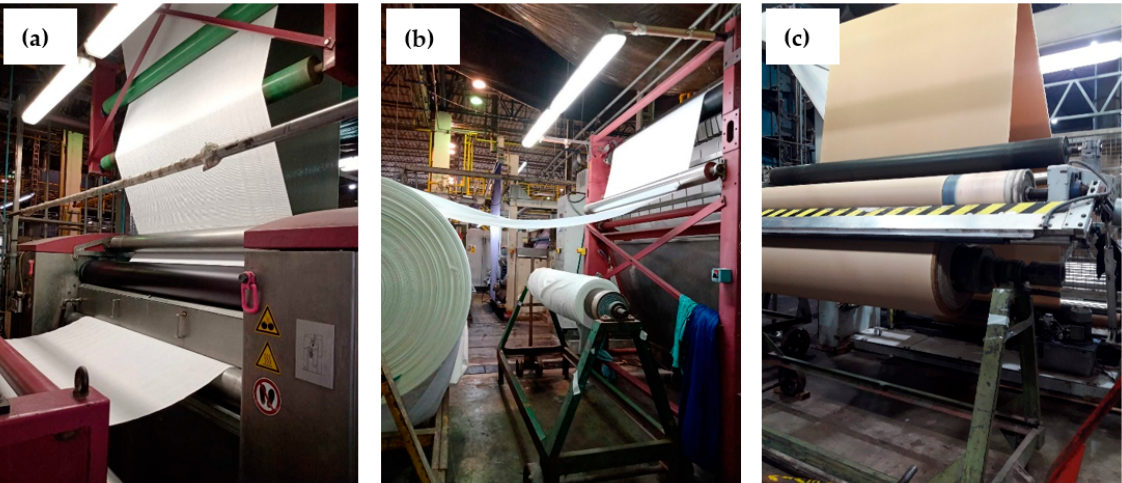
Figure 1. Industrial scaling: ( a ) before, ( b ) during, and ( c ) after the functionalization process of the PES/CO fabric with copper oxides.